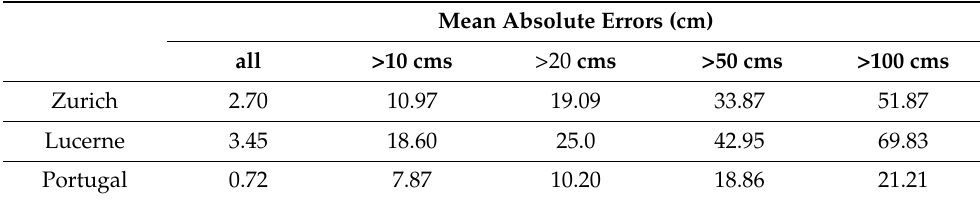
Table 3. Mean absolute errors (MAEs) in cm for Deep Flood models for different ranges of water depth and all rainfall events. Mean Absolute Errors (cm) all >10